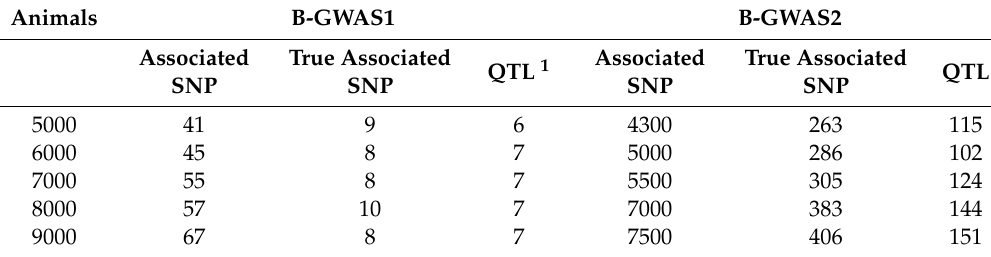
Table 3. Number of common QTLs detected by M-GWAS and T-GWAS, B-GWAS1 and B-GWAS2. M-GWAS vs.